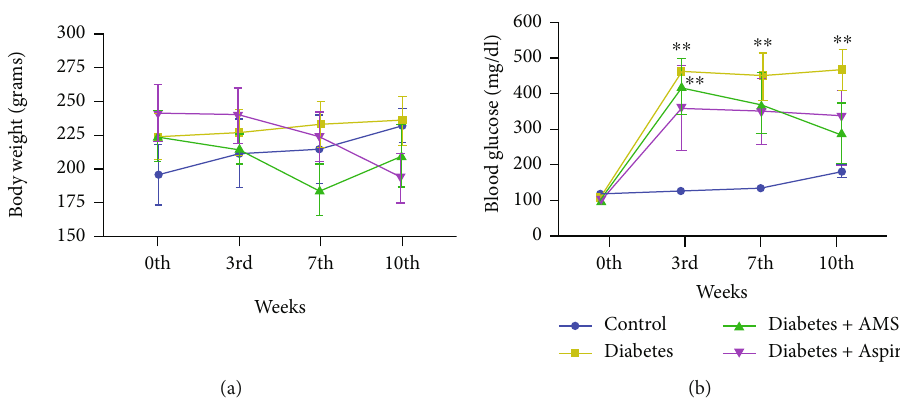
Figure 1: (a) Body weights and (b) blood glucose levels of the control, diabetes, AMS-treated, and aspirin-treated rats at the end of the 0 th , 3 rd , 7 th , and 10 th weeks. All values are represented as mean ± SEM ( N = 4 -6). ∗∗ p < 0 : 01 vs. the